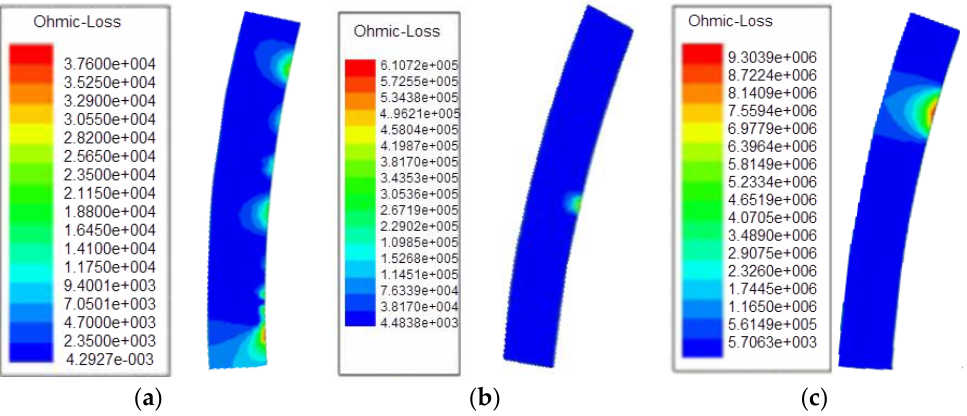
Figure 7. Internal eddy current loss distribution of the permanent magnet: ( a ) slot opening = 2 mm ( b ) slot opening = 4 mm, and ( c ) slot opening = 7 mm.